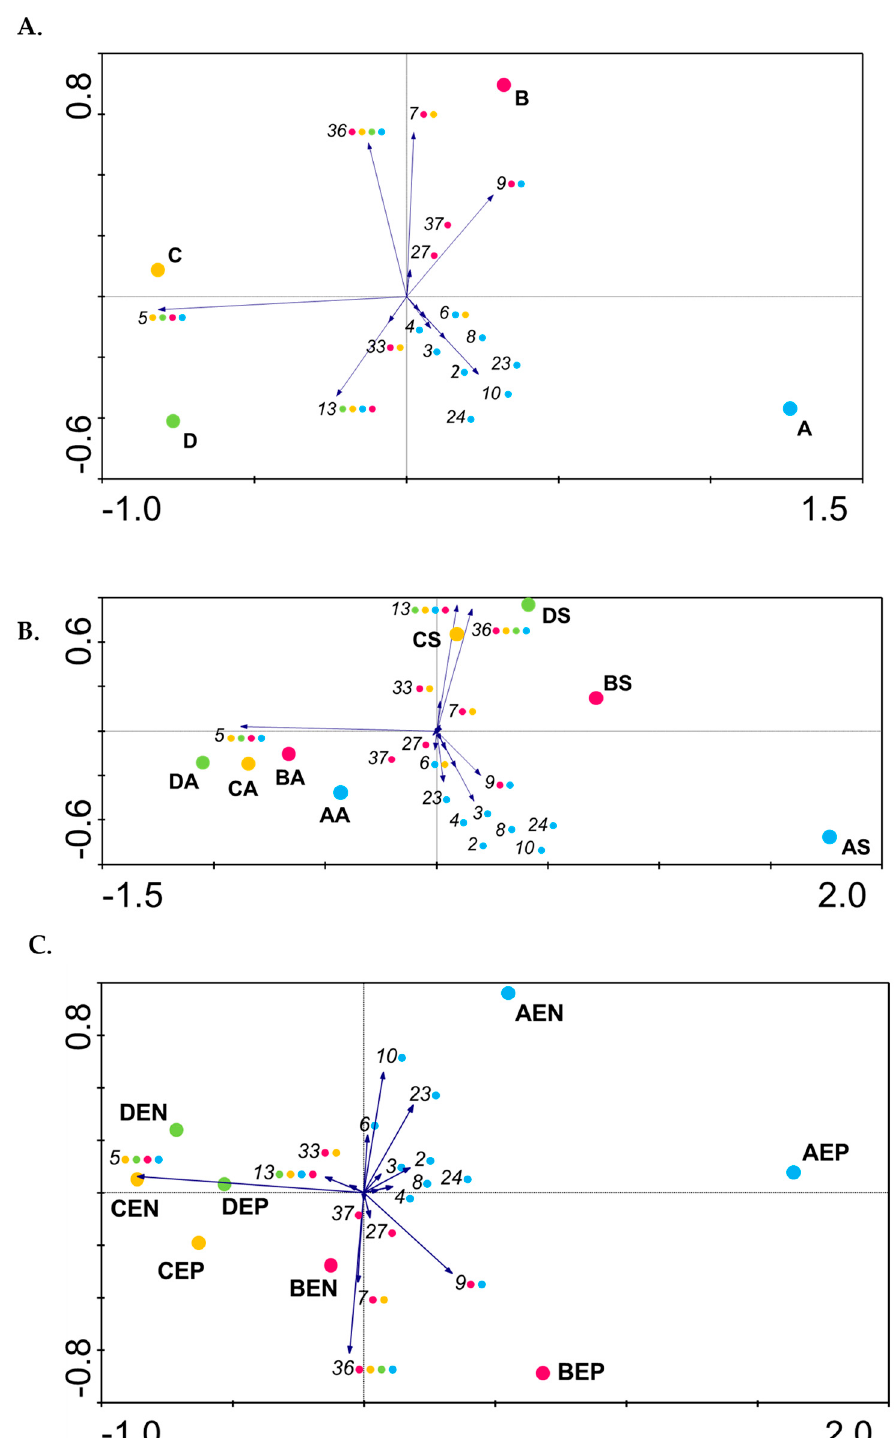
Figure 2. Principal Coordinates Analysis (PCoA) plots generated from Psa profiles identified in the four studied orchards using CANOCO 5 [58]. PCoA plots were constructed to ( A ) ascertain the distribution of Psa populations within and between orchards; ( B ) the distribution of Psa profiles in spring and autumn; and ( C ) the distribution of Psa profiles as epiphytic or endophytic profiles in the different orchards. Numbers correspond to Psa profiles and arrows identify the weight that each profile had on the diversity relationship between orchards. Blue, profiles isolated from orchard A (A); pink, from orchard B (B); yellow, from orchard C (C); green, from orchard D (D). A, autumn; S, spring; EN, endophytic; EP, epiphytic.